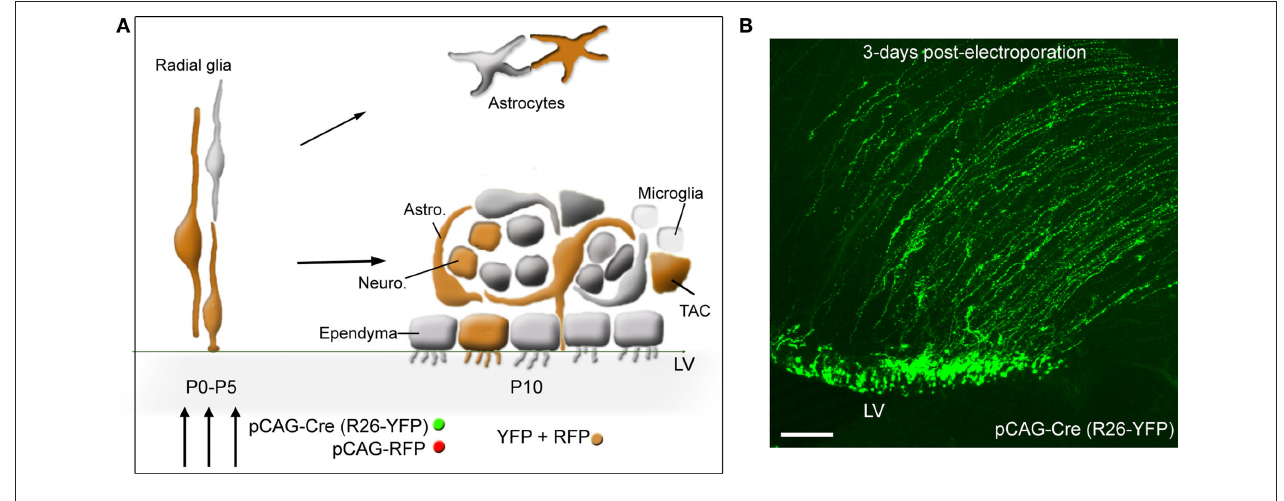
expression into radial glia, and thus in SVZ astrocyte-like cells and ependymal cells, and the progeny of astrocyte-like cells, i.e., TAC and neuroblasts that appear orange due to both RFP and YFP co-localization. The diagram assumes a 100% co-localization, which is experimentally 80–90%. (B) Confocal image illustrating the expression of yellow fluorescent protein (YFP) in radial glia following electroporation of a pCAG-Cre in Rosa26-YFP mice. Scale bar: 100